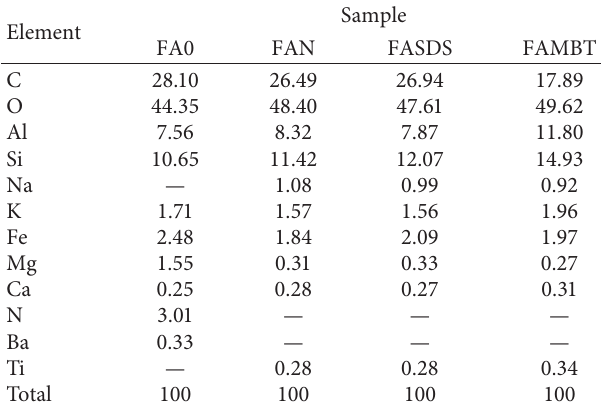
Figure 5: EDX spectra of FA0 (a), FAN (b), FAMBT (c), and FASDS (d). Table 2: Weight percent of elements in FA0, FAN, and modified FAN